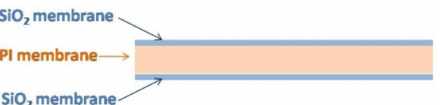
Figure 2. The schematic structure diagram of multilayer composite